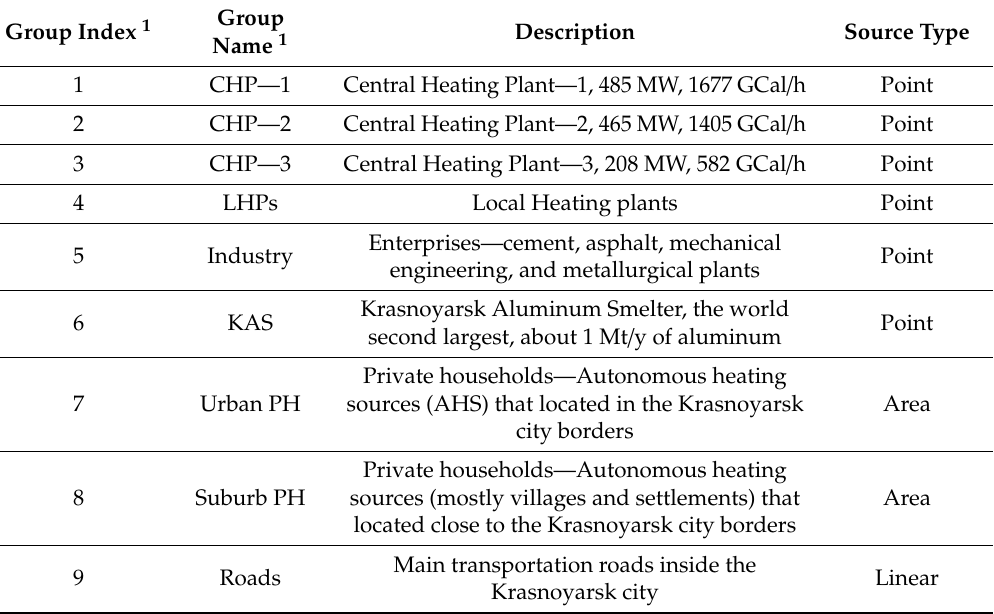
Table 4. The main groups of emission sources.